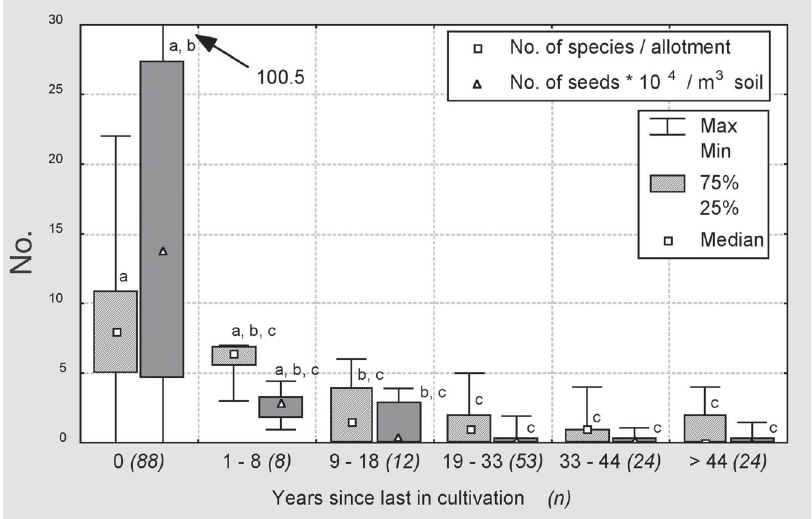
Fig. 1. Depletion of the seed bank of arable-land species following land-use change (soil sampling depth: 5–10 cm). a–c: values not sharing the same letter are signifi- cantly different at the 95% proba- bility level